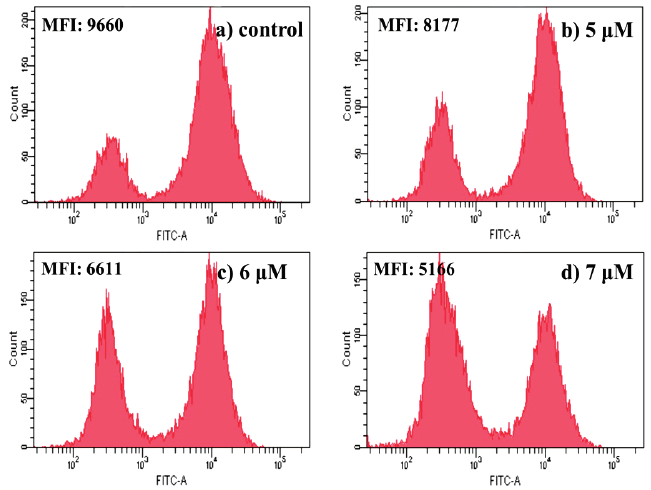
Figure 6. Effect of 4a on mitochondrial membrane potential: ( a ) control group; ( b ) 5 μ M; ( c ) 6 μ M; and ( d ) 7 μ M. Cells were determined by flow-cytometric analysis stained with Rhodamine 123 for 30 min. Results are expressed as mean fluorescent intensity